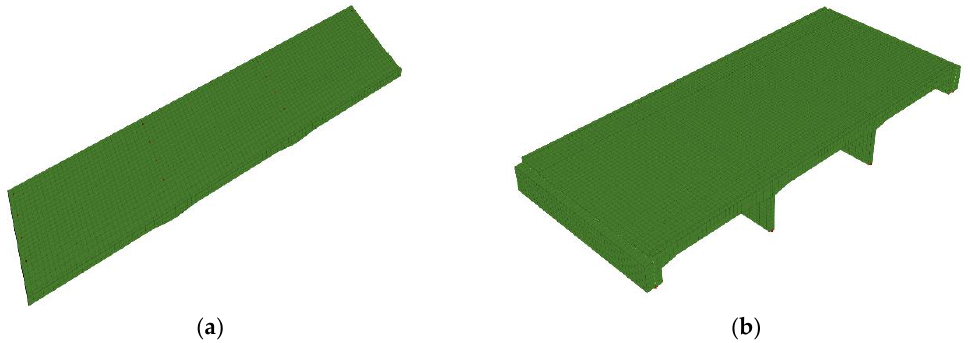
Figure 11. FE models for model updating: ( a ) Seolmun Bridge; ( b ) Gajwa